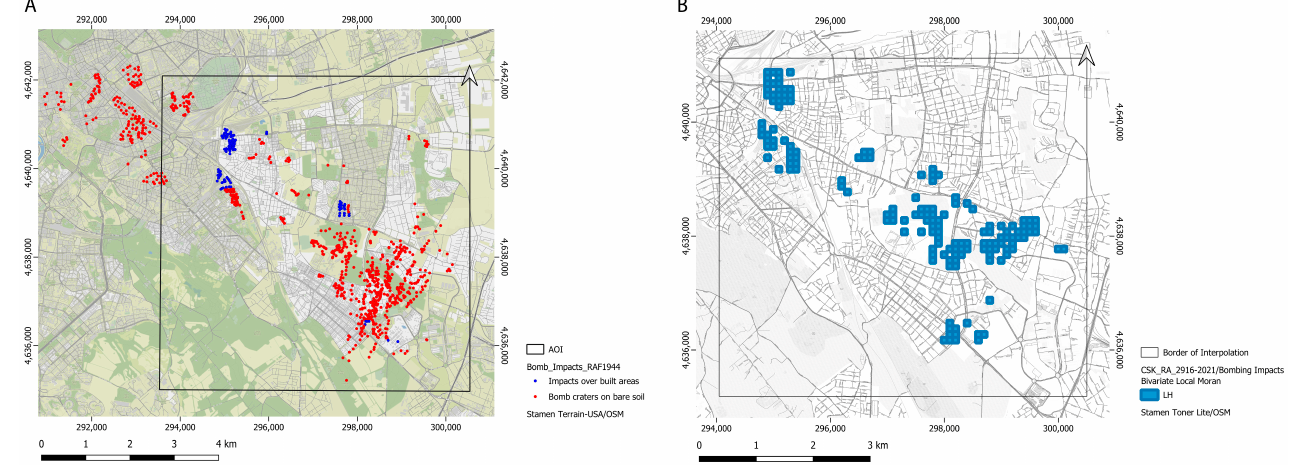
Figure 15. ( A ) Bomb impacts vector; ( B ) Bivariate Local Moran analysis to localize the correlation between the subsidence values recorded in the CSK-RA velocity map (cold clusters) and the hotspots of bomb impacts (hot clusters) in the Low/High (LH) class, shown in the picture as blue cells.